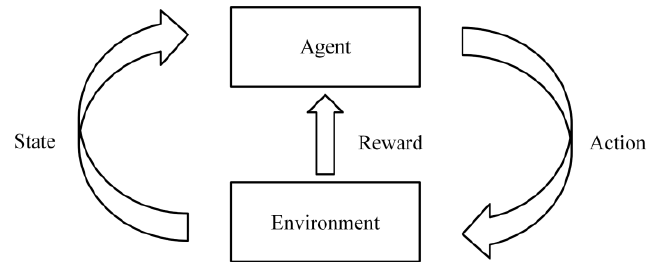
Figure 2. Reinforcement learning.